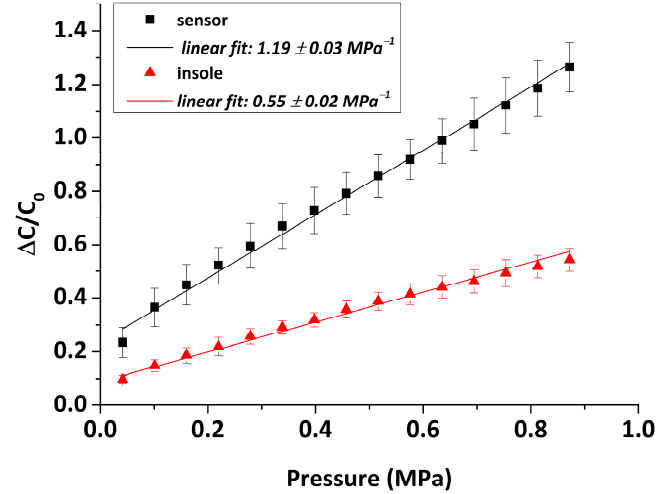
Figure 11. Average relative capacitance response of the 3D-printed capacitive pressure sensors as a function of the applied pressure measured outside (black) and inside the insole (red). The slopes correspond to the sensitivities.